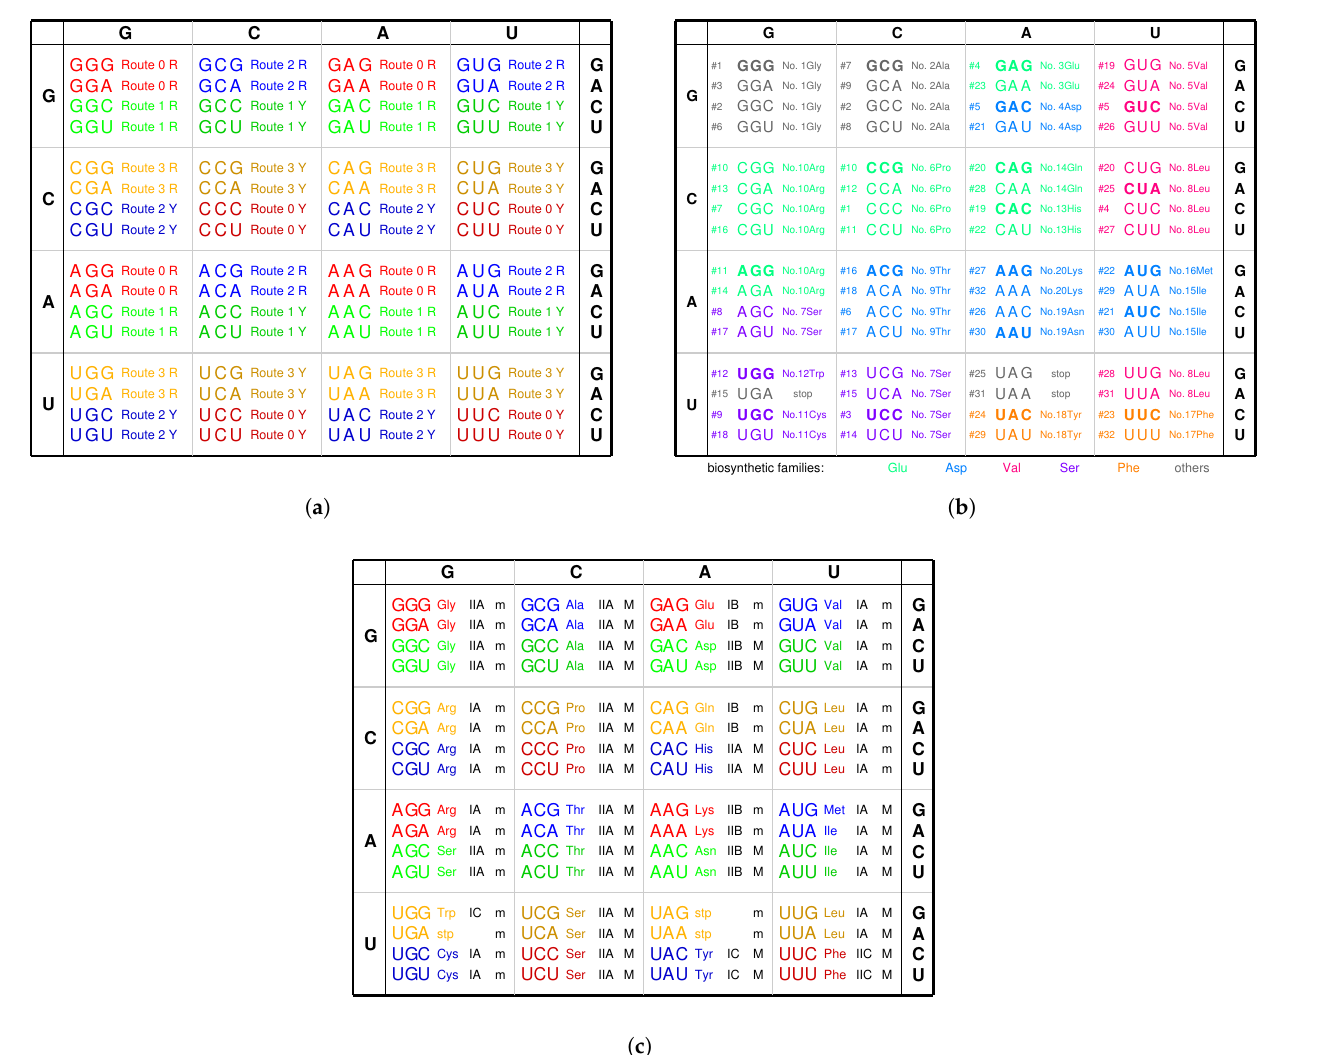
Figure 4. ( a ) The distribution of codons from R- and Y-strands of Route 0 − 3 in the GCAU genetic code table. The pattern of the 4 × 4 codon boxes for the degenerate codons relates to such a distribution of the four routes, owing to the evolution of the genetic code along the roadmap. ( b ) The GCAU genetic code table. The clusterings of biosynthetic families (Glu, Asp, Val, Ser, Phe) in the GCAU genetic code table. Such nice clusterings are correspondingly observed in the R- and Y-strands of Route 0 − 3 in Figure 3b (denoted in the same group of colour as in the present figure). The clusterings of biosynthetic families in the present figure are closely related to the distribution of codons from R- and Y-strands of Route 0 − 3, owing to the recruitment of amino acids along the roadmap. Generally speaking, the amino acids are arranged properly in the recruitment order from No .1 to No .20 along the direction from G , C to A , U in the GCAU genetic code table. ( c ) The distribution of types of aaRSs in the GCAU genetic code table. The aaRSs can be divided into Class II and Class I , which can be divided into subclasses IIA , IIB , IIC and IA , IB , IC , respectively. The aaRSs can also be divided into minor groove ones ( m ) and major groove ones ( M